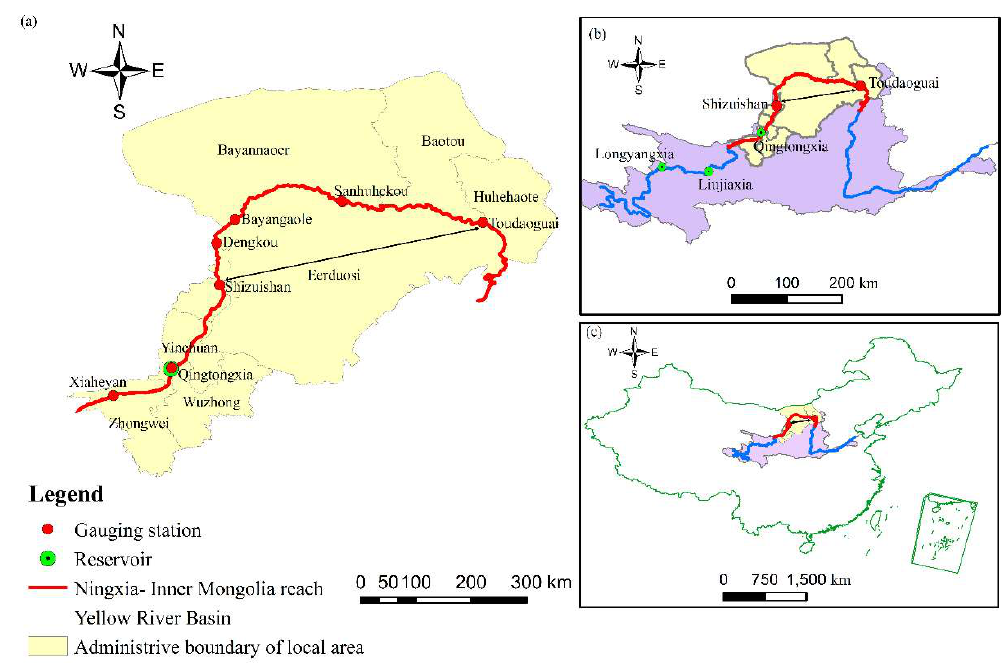
Figure 1. Location of study area: ( a ) the drainage area of the Ningxia-Inner Mongolia Reach; ( b ) the entire drainage basin of the Yellow River; ( c ) location of the Yellow River drainage basin in China.